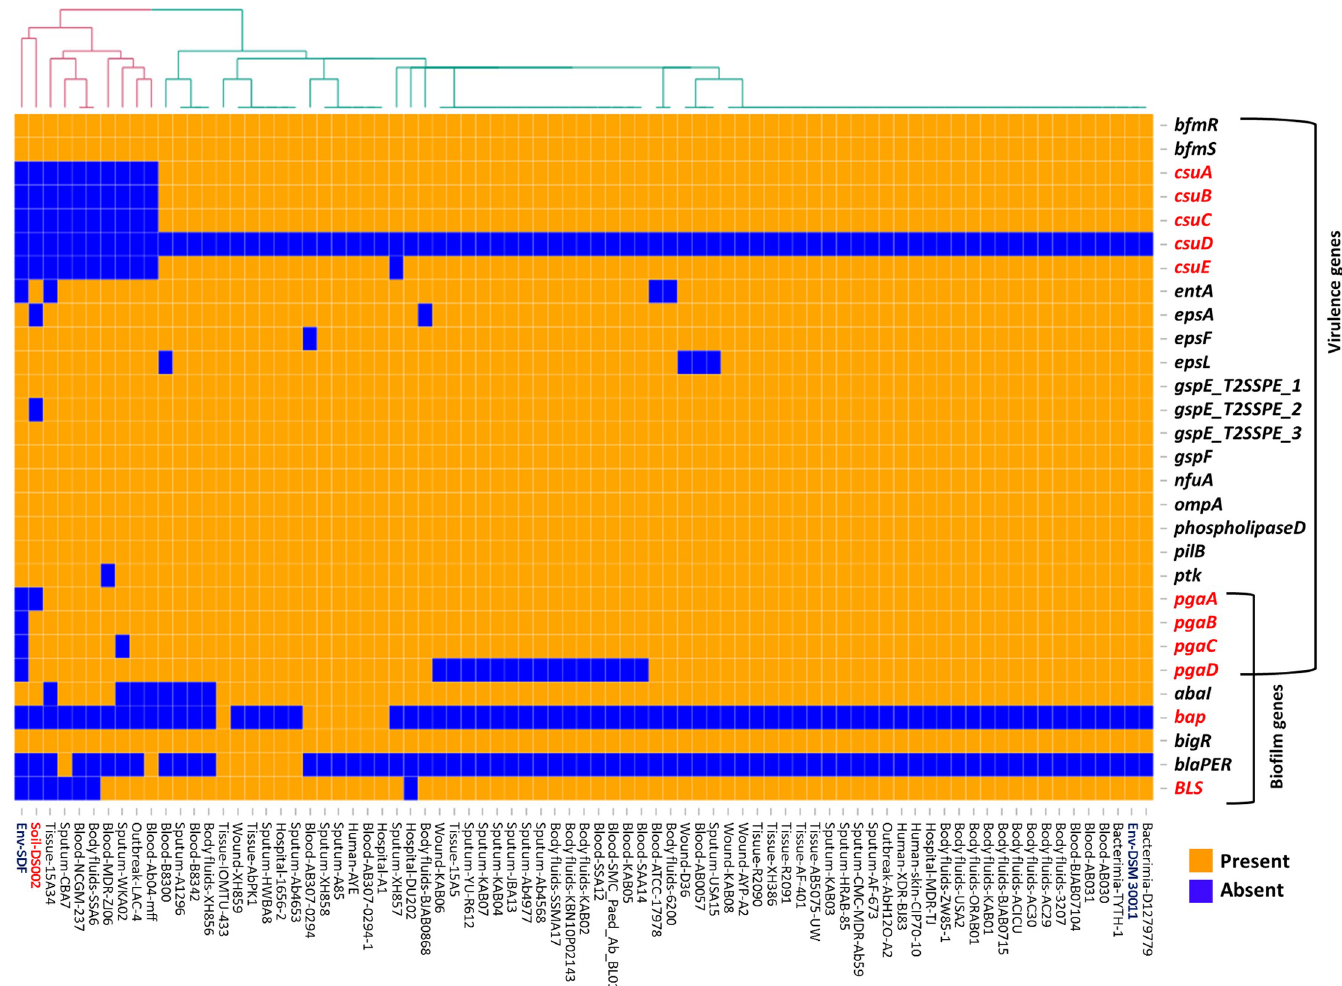
Fig 5. Heat map showing LS-BSR analysis of genes involved in virulence. Genes extensively discussed in the text as well as the strain DS002 are highlighted in red font.